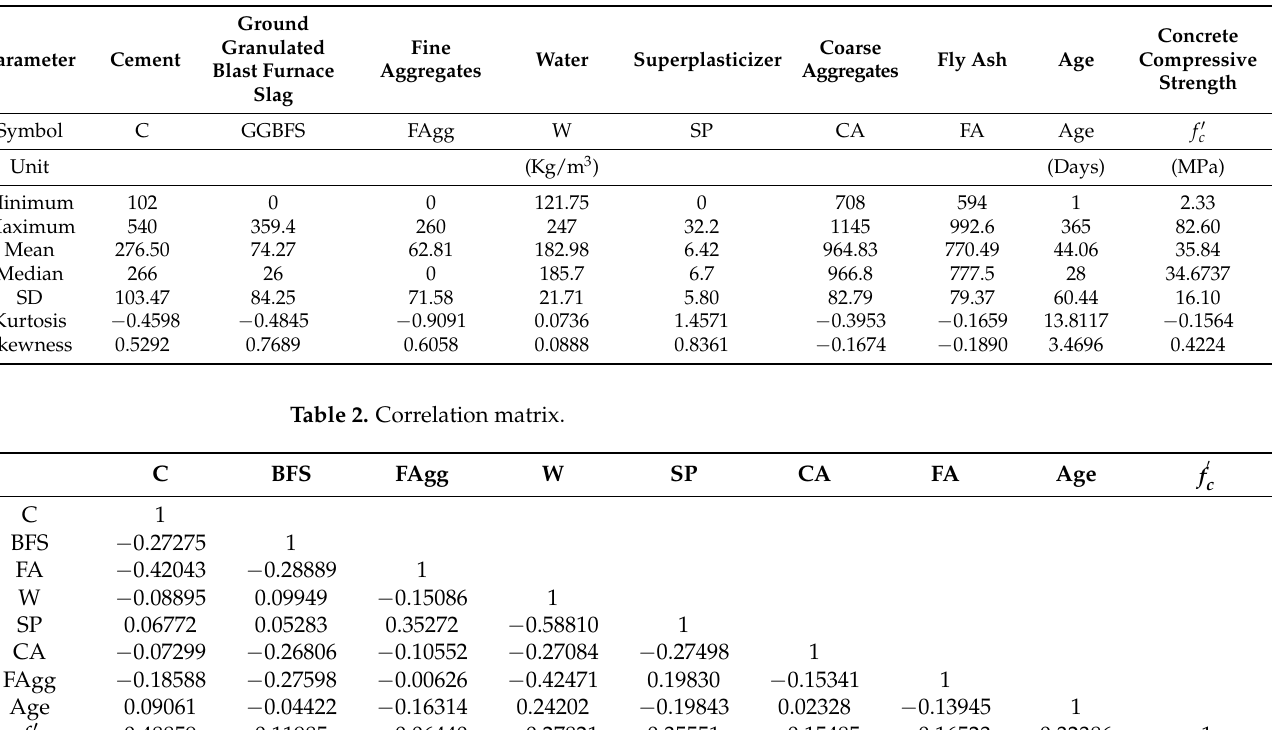
Table 1. Statistical functions for input and output parameters.